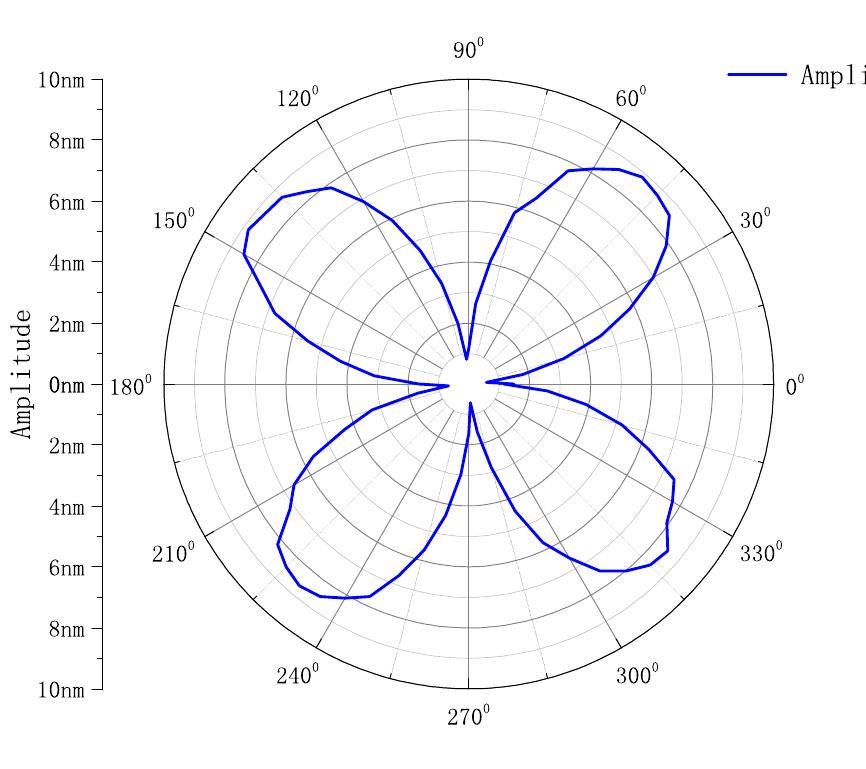
Figure 14. Mode shape of the resonator.